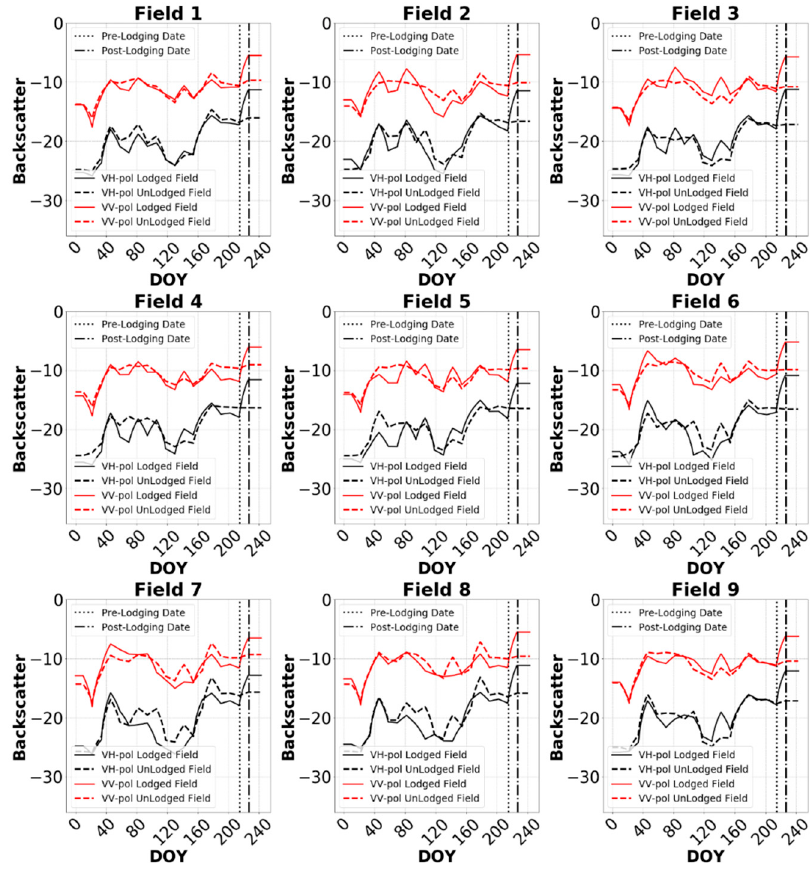
Figure 13. Time series of lodged and un-lodged fields. Remote Sens. 2020 , 12 , x FOR PEER REVIEW